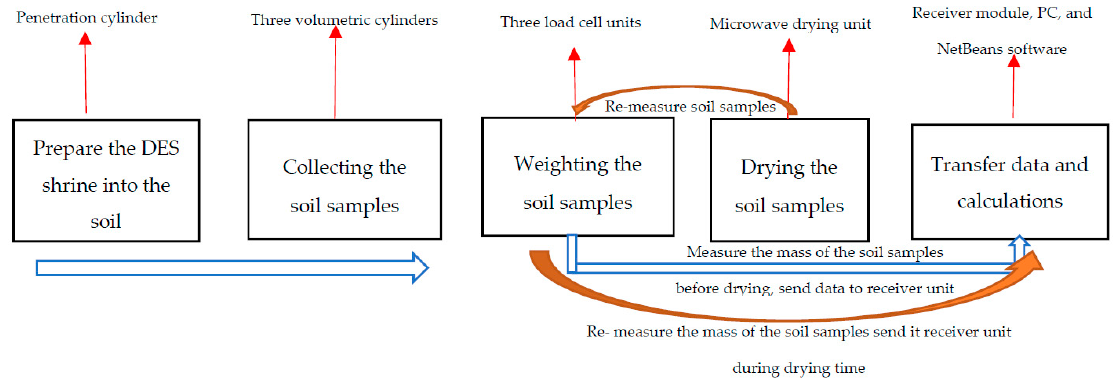
Figure 4. Schematic diagram of the working mechanism of the DES.